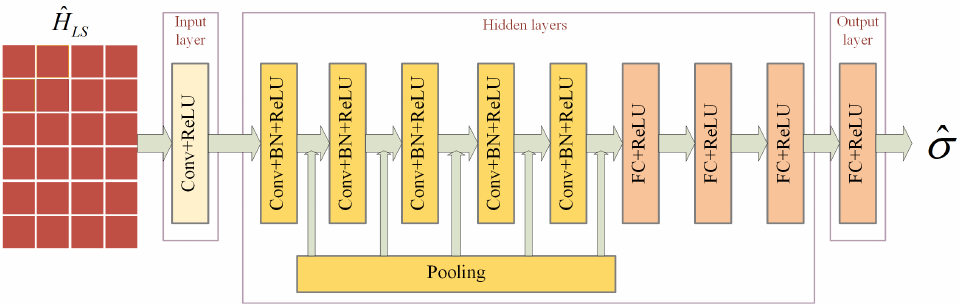
Figure 4. The network structure of the